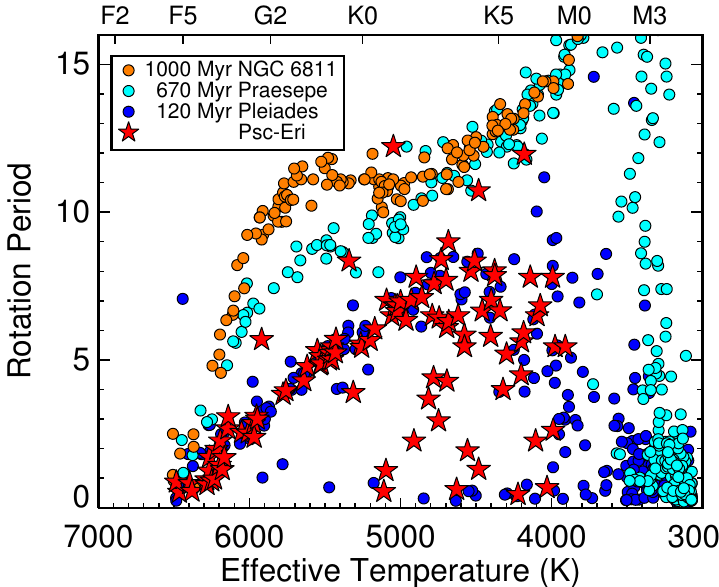
Figure 9. Relation between colour (effective temperature) and rotation period for stars in three well-studied clusters and for the Pisces–Eridanus structure. The Psc–Eri structure appears indistin- guishable from the Pleiades, indicating that they are of very similar age. Reproduced from [206] with the permission of the authors and the